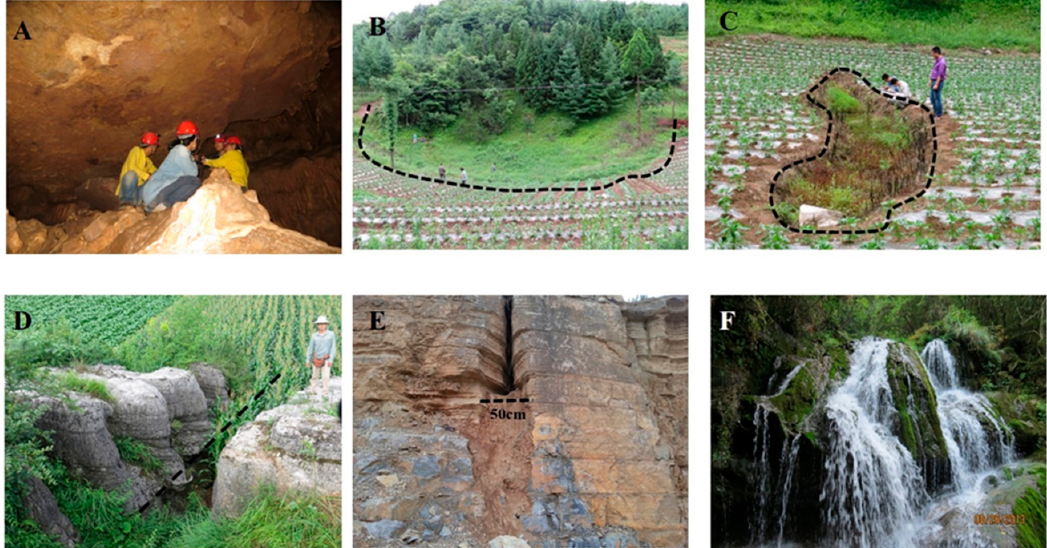
Figure 2. Some karst features located in Miaogou watershed and environs ( A ) Xiaosanyou Cave; ( B ) doline with dotted lines enunciating the perimeter; ( C ) large sinkhole with dotted lines enunciating the perimeter; ( D ) vracture with dotted lines enunciating the orientation of fracture; ( E ) epikarst; and ( F ) bailongquan spring.